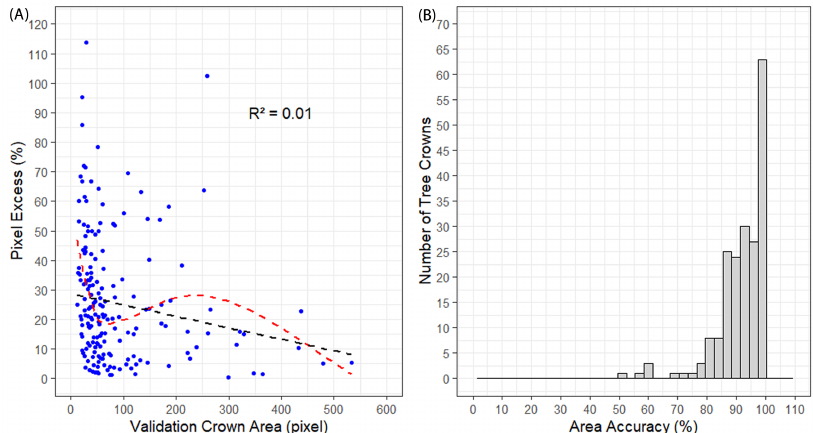
Figure 12. ( A ) Evaluation of the association between crown area (in pixel) and the pixel excess. The black dashed line corresponds to the linear model fit and the red dashed line is the local polynomial fit; ( B ) The frequency of the right percentage of the tree crown area estimated by Mask R-CNN. The pixel excess and deficit frequency had a normal distribution with a mean of − 6.1 pixels and a standard deviation of 65.5 pixels (see Figure